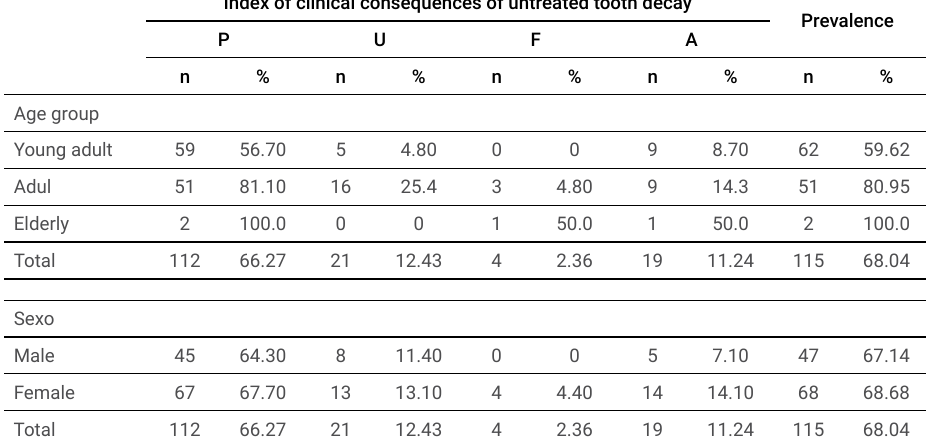
Table 4. Frequency of components of the PUFA index of the inhabitants of native communities, according to age group and sex. Index of clinical consequences of untreated tooth decay